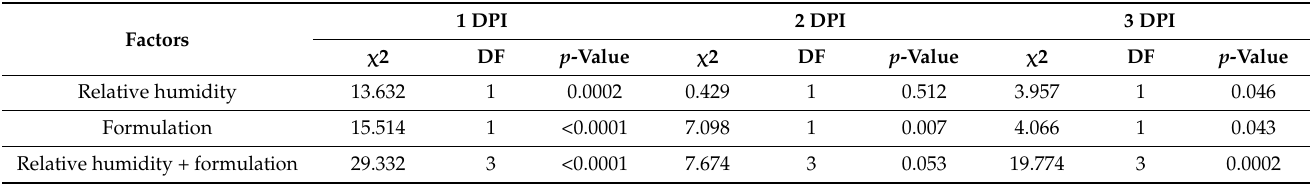
Figure 7. Illustrations of the various disease stages. In order to quantify disease progression, the disease caused by M. brunneum was sectioned into six stages: ( A ) No adhered conidia on the insect’s cuticle. ( B ) Adhered, non-germinated conidia on the cuticle. ( C ) Conidial germination and appressorium formation. ( D ) Cuticle penetration, up to 5% of hemocoel colonization. ( E ) Early infection (colonization of 5–50% of the hemocoel). ( F ) High infection (colonization of over than 50% of the hemocoel). Table 7. Statistical significance of various factors on disease progression, as examined by a non-parametric Wilcoxon text, by day